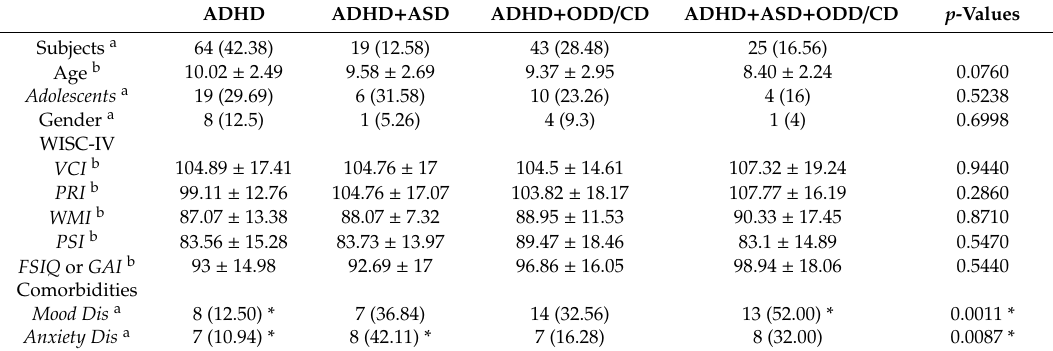
Table 1. Demographic and clinical data.